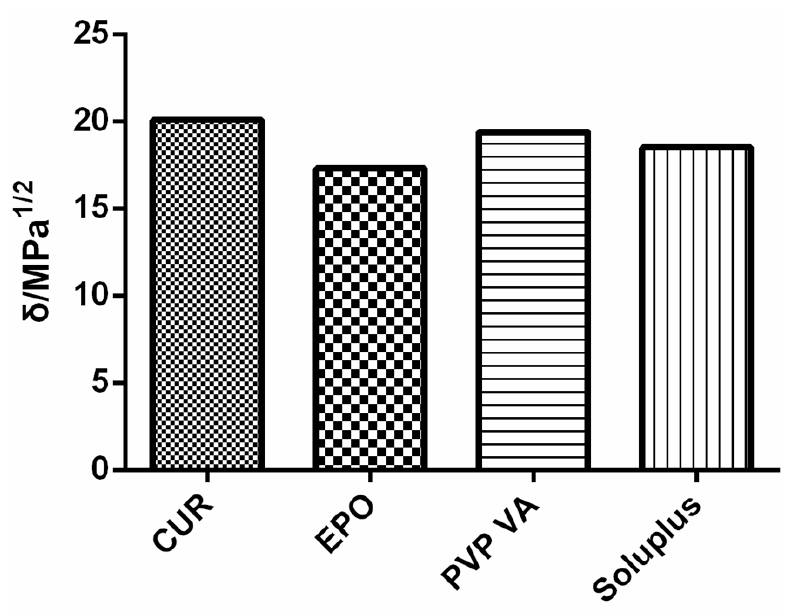
Figure 2. Solubility parameters of samples.